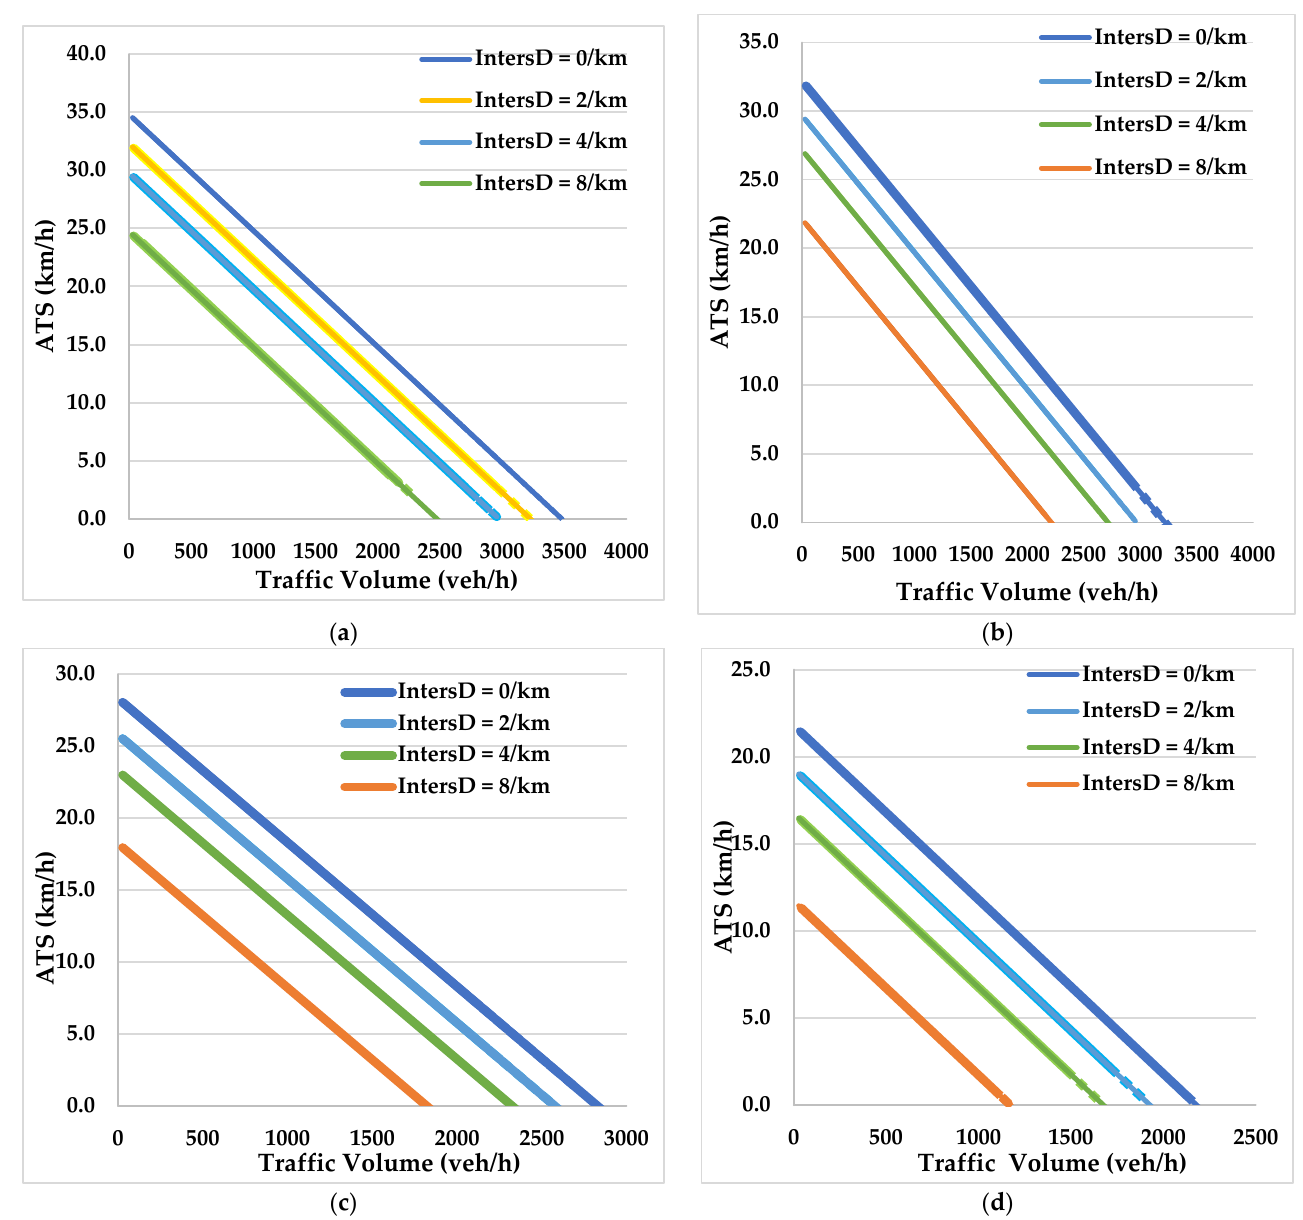
Figure 11. ( a , b ) Speed-flow models for road’s category [M0, NL1, SF1] for TCSD = 0/km, and 2/km. ( c , d ) Speed-flow models for road’s category [M0, NL1, SF1] for TCSD = 5/km, and 10/km.